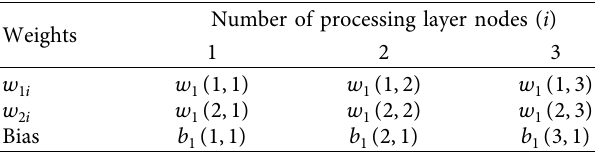
Table 1: Weight and bias values between input and processing layers.